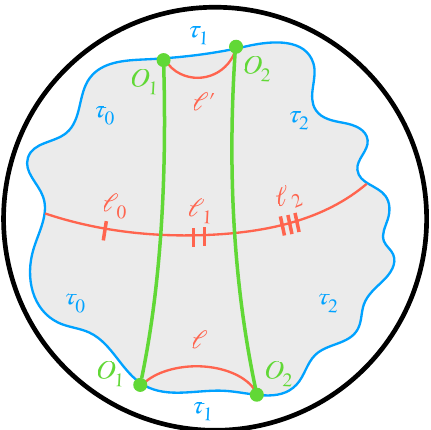
Figure 11 . JT gravity with 2 particles in the wormhole. Cutting open the diagram on a geodesic gives a bulk Hilbert space with 3 lengths ‘ 0 , ‘ 1 , ‘ 2 . To evaluate this diagram, one can cut the diagram along the asymptotic geodesics (lengths ‘ 1 = ‘ and ‘ 1 = ‘ 0 ) in the Euclidean past and future. One then sews on a cap h ‘ | τ 1 i